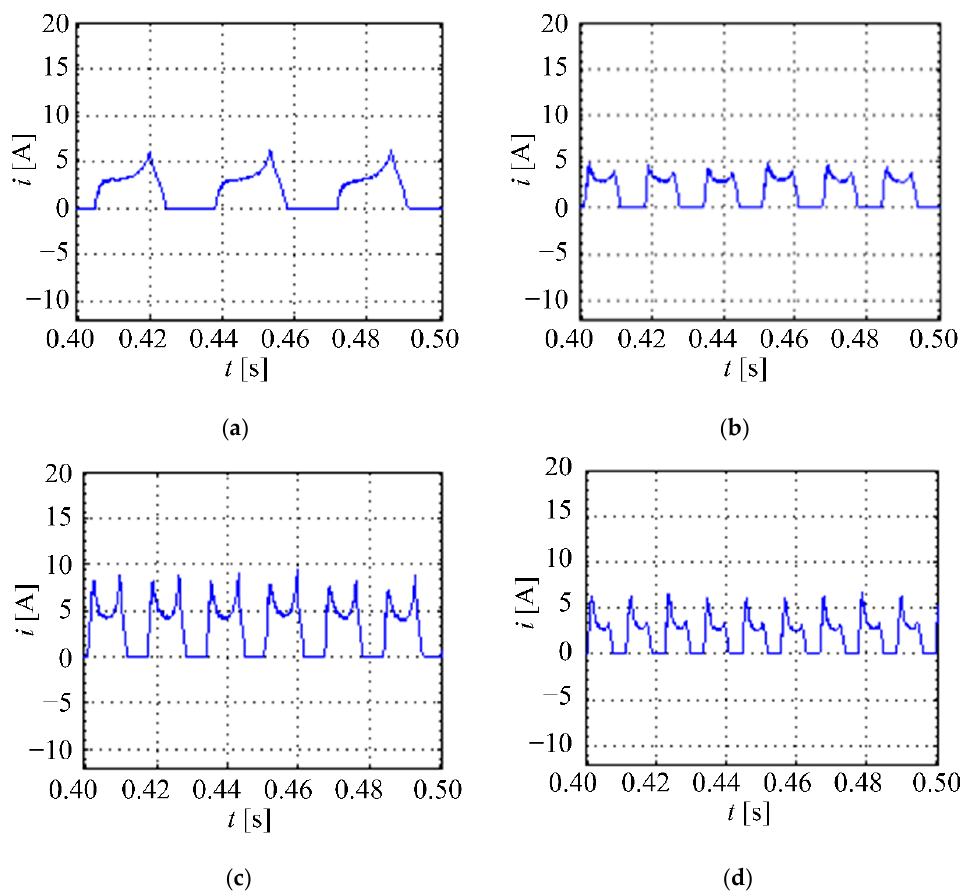
Figure 16. Phase current waveforms of the analyzed SRM machine: ( a ) the rotor speed is n = 300 rpm and the load is T = 0.5 Nm; ( b ) n = 600 rpm and T = 0.5 Nm; ( c ) n = 600 rpm and T = 1.0 Nm; ( d ) n = 900 rpm and T = 1.0 Nm.